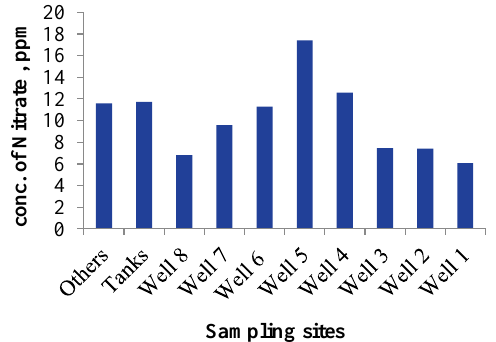
Figure 4. The average of Nitrate (mg/l) in well, Tanks and others 2008-2013 On the other hand, all the nitrate concentrations were less than 50 mg/l. It looks like raw sewage disposal of urban and rural areas was the main source of nitrate ions in municipal water supplies. As figure 5 shows, the concentration of nitrate during these years remained the same.